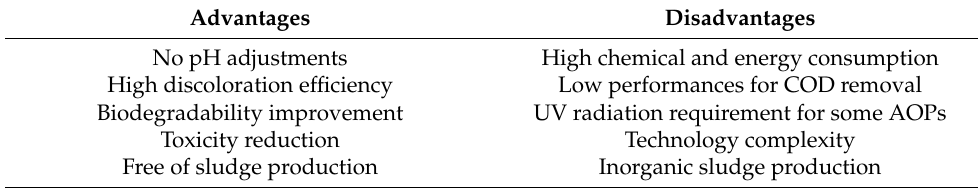
Table 4. Key advantages and disadvantages of AOPs used for dye